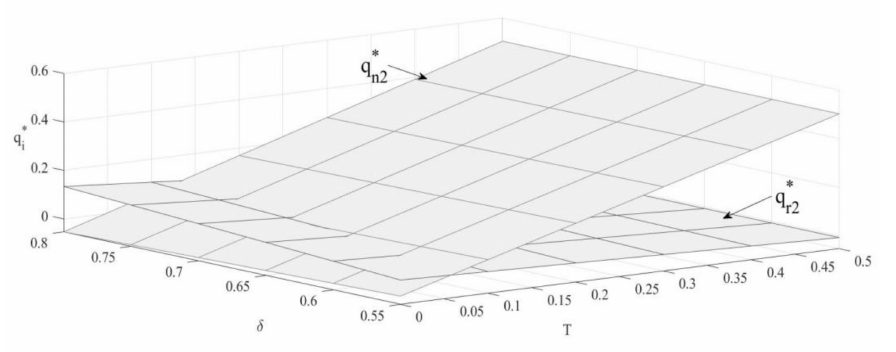
Figure 2. The impact of T and δ on sales